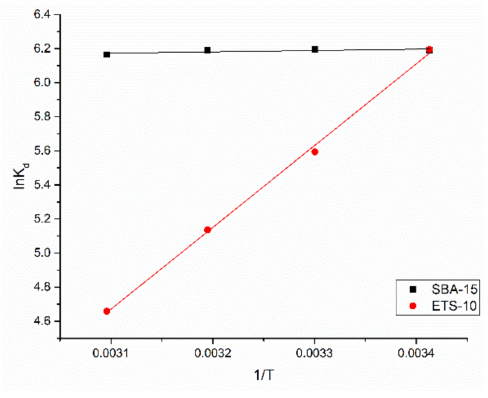
Figure A2. ln K d versus 1/ T